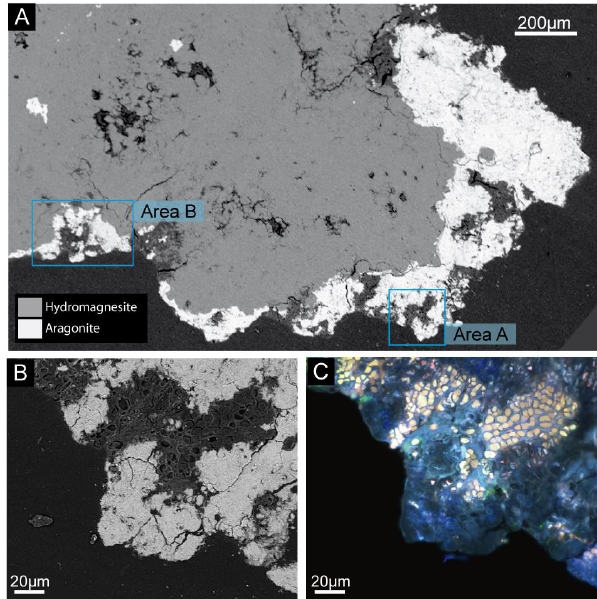
Fig. 1. Images of a section prepared from an Alchichica microbialite collected at a 4m depth. (A) SEM (backscattered electron mode) picture of the section showing the relative distribution of mineral phases. Aragonite (white) lies mostly at the surface of the microbialite while hydromagnesite (light grey) composes the inner part. LR-white resin appears in dark-grey around the sample. Pockets of microorganisms are visible in aragonite, for instance in area A and area B. (B–C) Close-ups of area A obtained by SEM (B) and CLSM (C) . Some residual autofluorescence underline cell ghosts in the aragonitic part.